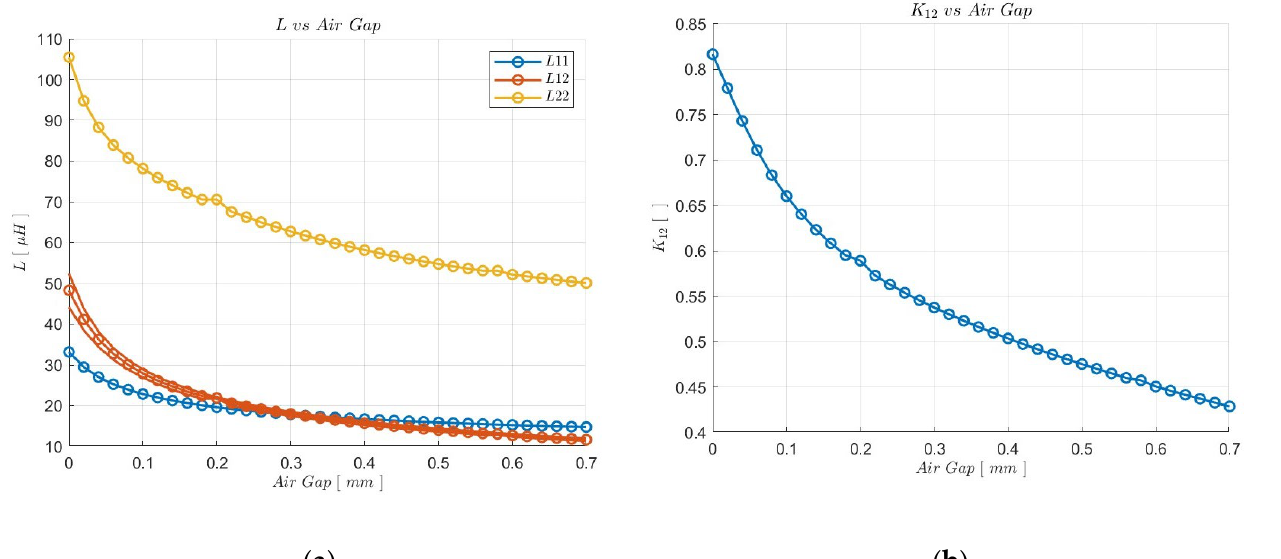
Figure 5. ( a ) Auto and mutual-inductance parameters vs. air gap variation; ( b ) coupling factor vs. air gap variation.